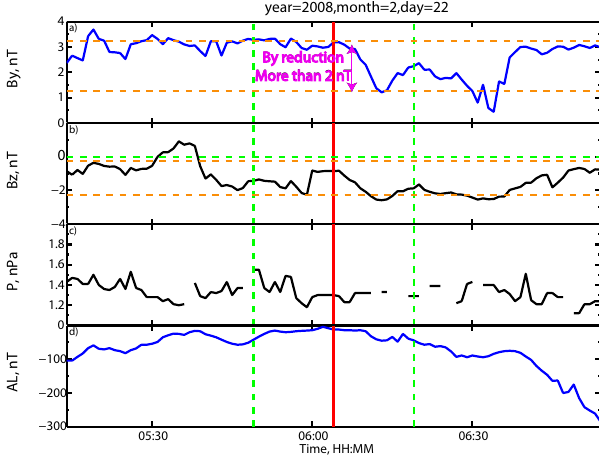
Fig. 1. Example of a B z -triggered event applying the criteria based on Lyons et al. The first panel (a) represents B y , (b) shows B z , (c) indicates dynamic pressure and (d) AL index. The red line indi- cates the onset time. The two vertical green lines indicate ± 15min around the onset time. The horizontal orange lines indicate a 2nT change of the IMF B z starting at the initial point of the northward turning. The horizontal blue line indicates the location of zero for reference.